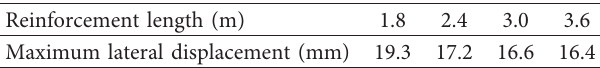
Table 5: Comparison of maximum lateral displacement of the wall panel.